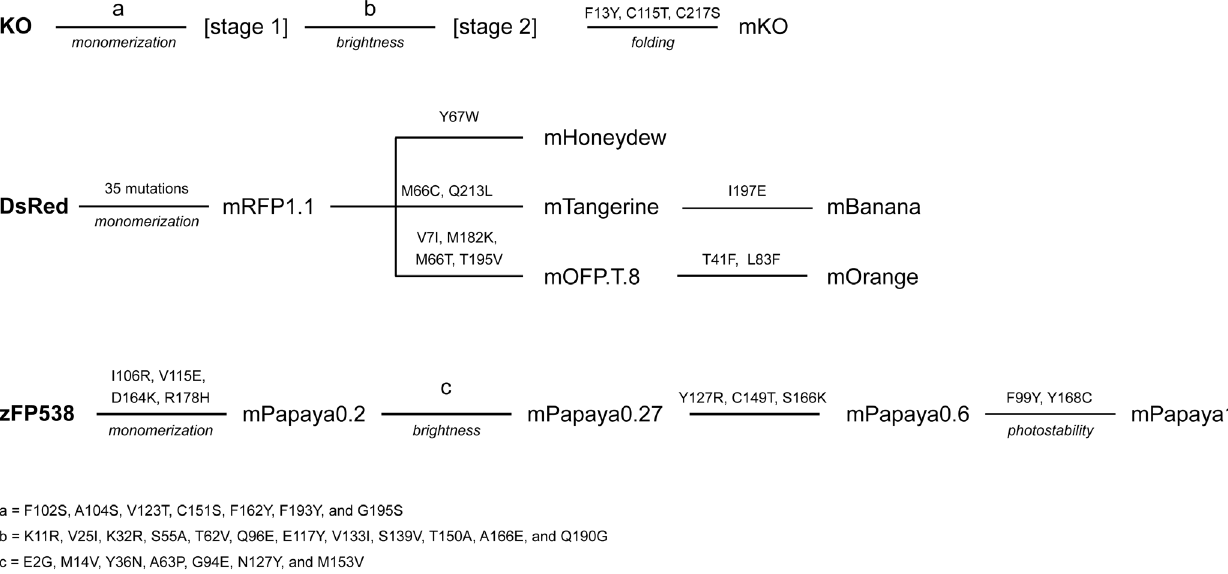
Figure 6. An evolution of orange fluorescent proteins derived from KO, DsRed and zFP538 with mutations critical to the phenotype of each variant.